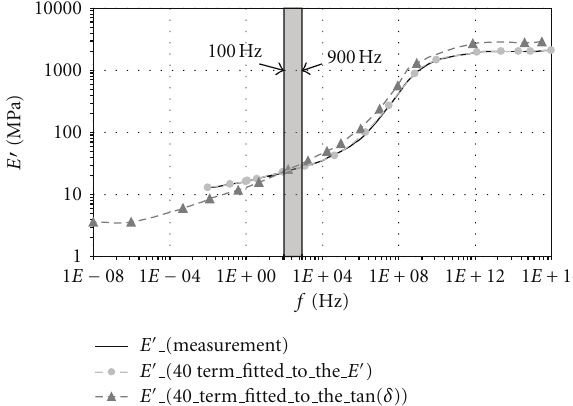
Figure 6: tan( δ ) versus frequency curves of EPDM v1 in the case of 10-term generalized Maxwell-model at room temperature and at temperatures of T = − 45 ◦ C and − 35 ◦ C.